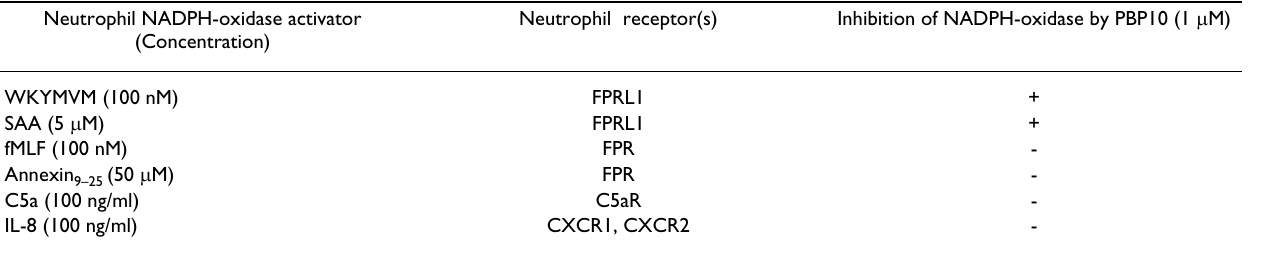
Abbreviations: C5a, complement 5a; FPR, formyl peptide receptor; IL-8, interleukin 8; SAA, serum amyloid